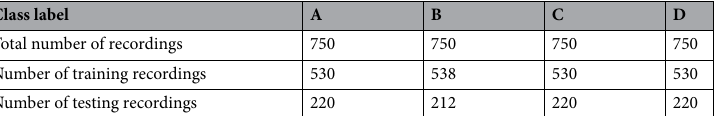
Table 1. The number of recordings. Each recording is a 5 min audio file in WAV format. Each recording will be sliced into 100 segments as samples to make up the input of neural networks. Each segment has 3 s duration.